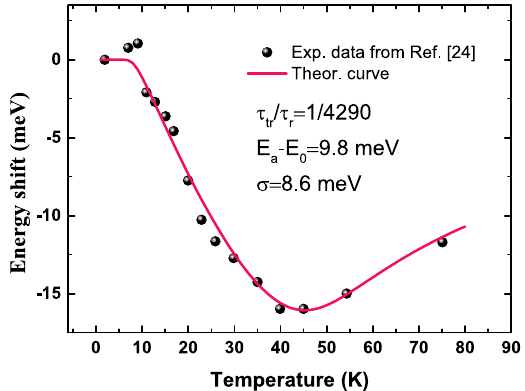
Figure 1. Temperature induced luminescence peak shift of localized carriers in an InGaN/GaN quantum well. The experimental data (solid circles) were measured by Schömig et al. 24 , whereas the solid line was a best fitting curve with Eqs (3) and